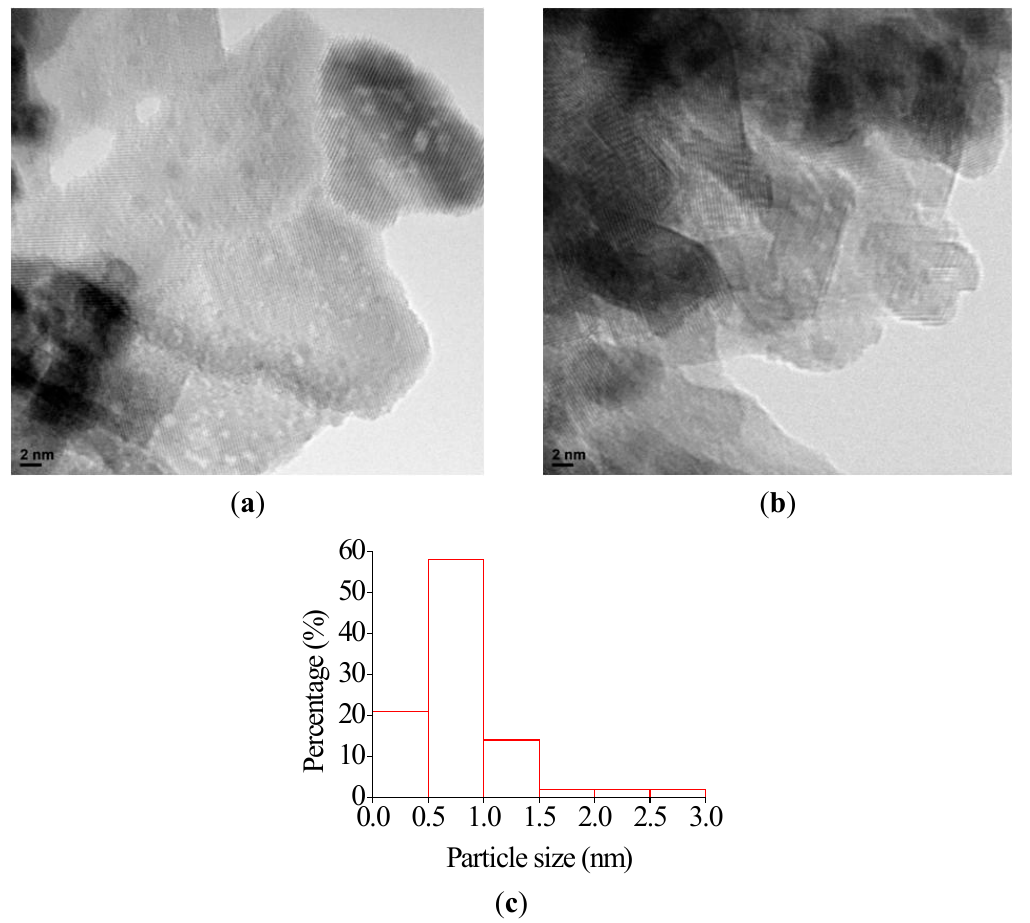
Figure 8. TEM pictures of catalysts ( a ) Rh25Ce25; ( b ) Rh250Ce25 and ( c ) particle size distribution of rhodium for